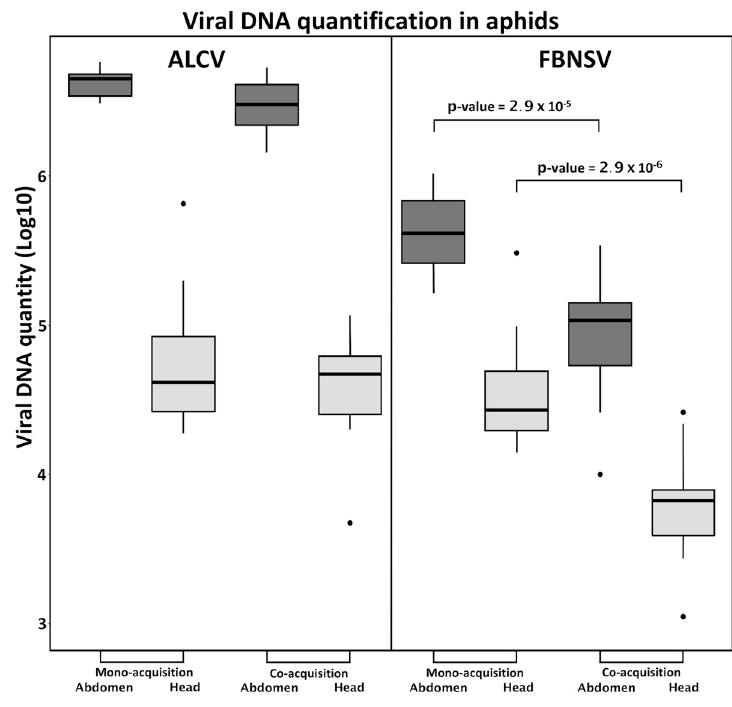
Figure 2. Accumulation of FBNSV and ALCV in aphid vectors. The box-plots represent the amounts of viral DNA (log10 of copy number) of ALCV and FBNSV in the abdomens (dark grey) and heads (light grey) of A. craccivora . The box-plots are from pools of five abdomens or heads with n = 11 for monoinfection and n = 15 for coinfection. p -values given result from testing the differences in FBNSV DNA amounts in heads or abdomens of aphids that have acquired FBNSV from mono-infected versus co-infected plants.